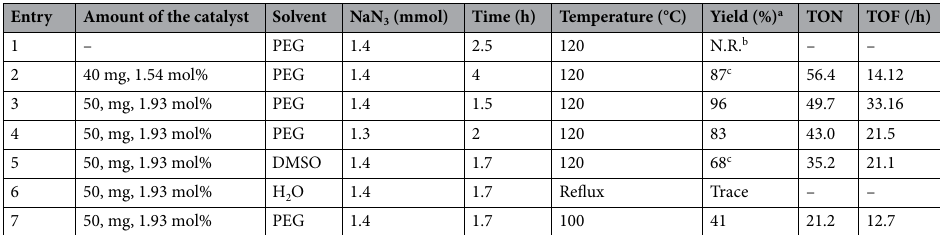
Table 3. Definition of the best reaction conditions for synthesizing 5-substituted 1H-tetrazoles in presence of Sm-bis(PYT)@boehmite. a Isolated yield within 120 min. b No reaction. c Isolated by thin-layer